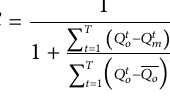
Frontiers in Environmental Science |